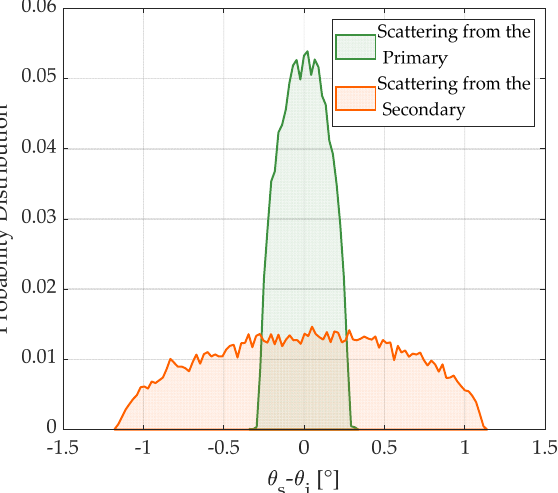
Figure 9. The probability distribution of the scattered ray deviation from the specular reflected direction.